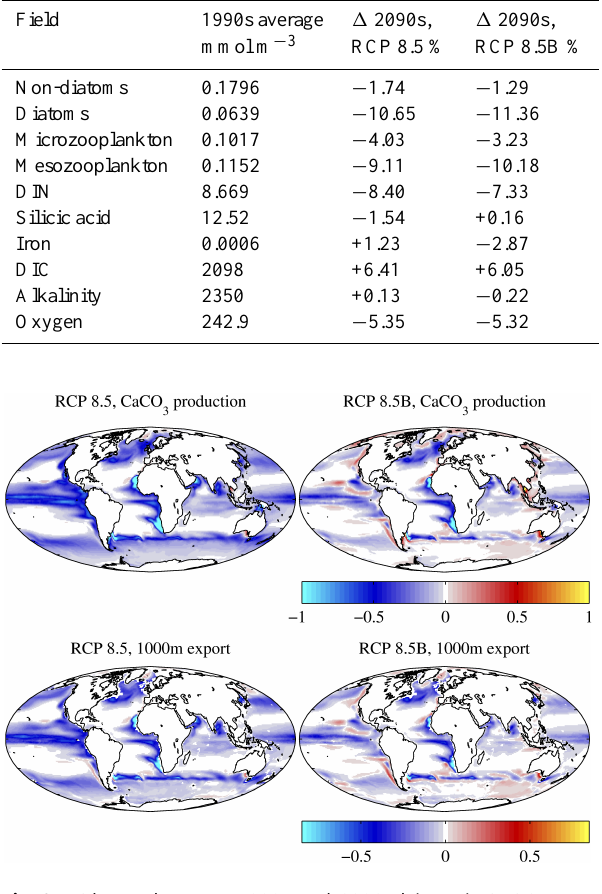
Fig. 21. Change between 1990s and 2090s biogenic CaCO 3 pro- Fig.19. Changebetween1990sand2090sbiogenicCaCO 3 production( top ;mmolCm − 2 d − 1 )andexportproduction at1000m( bottom ;mmolCm − 2 d − 1 )fortheRCP8.5( left )andRCP8.5B( right )simulations. duction (top; mmolCm − 2 d − 1 ) and export production at 1000m (bottom; mmolCm − 2 d − 1 ) for the RCP 8.5 (left) and RCP 8.5B (right)